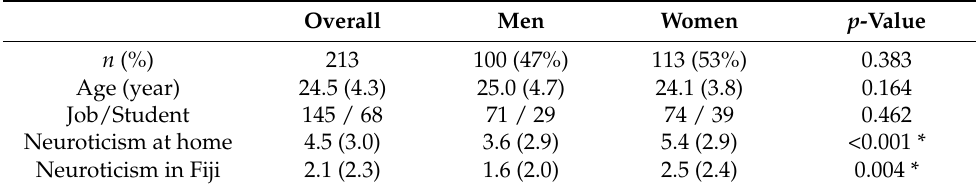
Table 1. Demographics and study outcomes. Overall